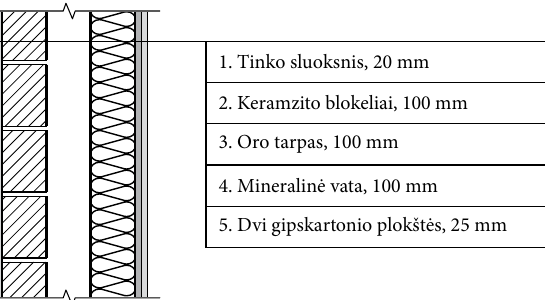
Table 3. Improvement of airborne sound insulation